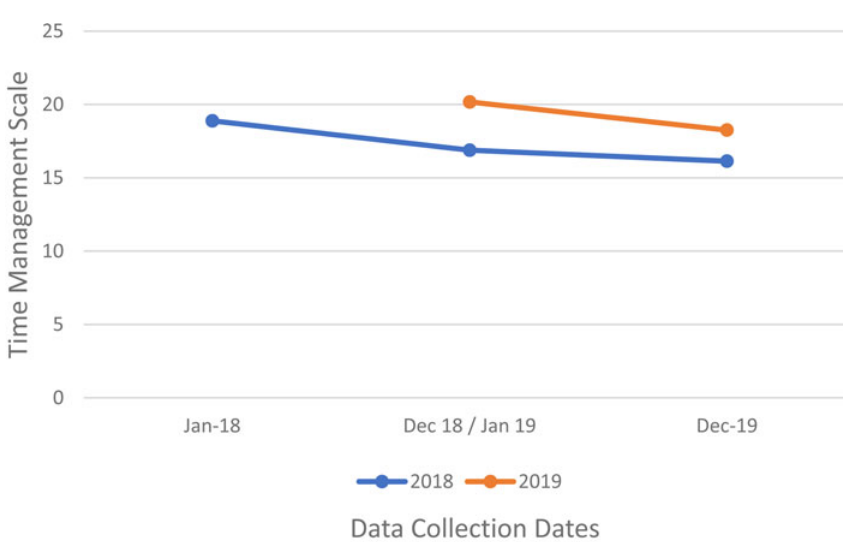
Fig. 4. Time Management Mean Scores for 2018 & 2019 Cohorts